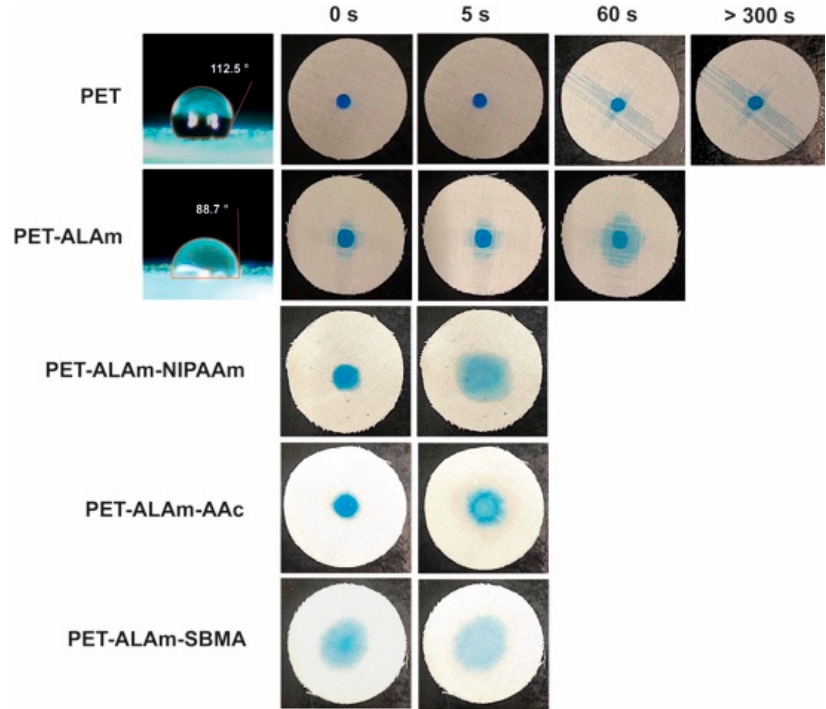
Figure 2. Photographs show wettability measurements on the pristine and modified PET fabrics using both contact angle measurements (sessile drop) and drop penetration tests.